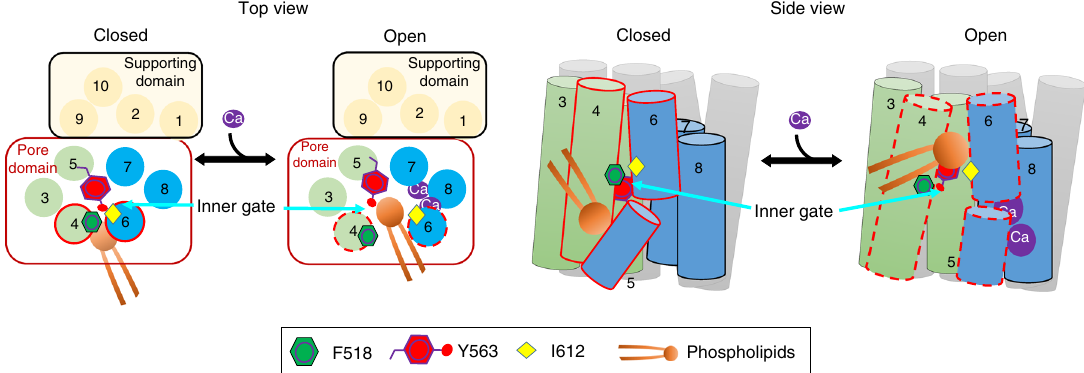
Fig. 7 A clam shell model for TMEM16F-CaPLSase gating. In each subunit, TMs 3 – 8 enclose a hydrophilic phospholipid permeation pathway. The interface between TM4 and TM6 guards the inner activation gate, precluding phospholipid access to the hydrophilic pathway when Ca 2 + is absent. Ca 2 + binding triggers the separation of TM4 and TM6, leading to the opening of the inner activation gate and subsequent phospholipid permeation. Reducing size or increasing hydrophilicity of the inner activation gate residues weakens the TM4 – TM6 interface, thereby enhances phospholipid